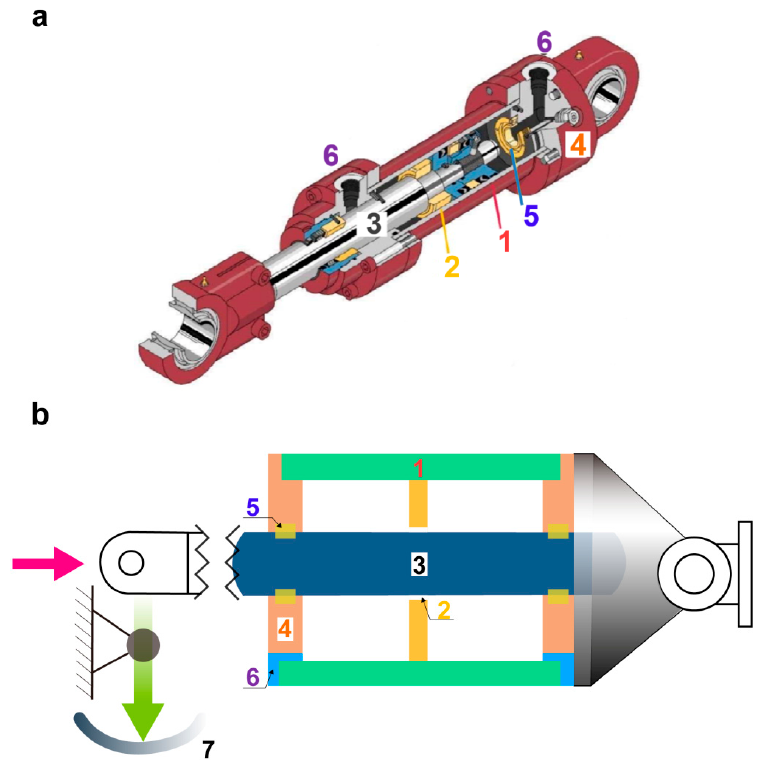
Figure 1. ( a ) Physical map and ( b ) Working principle of the hydraulic servo-actuator. 1. Cylinder; 2. Piston; 3. Piston rod; 4. End cap; 5. Seal ring; 6. Pipe orifice; 7. Signal feedback device.